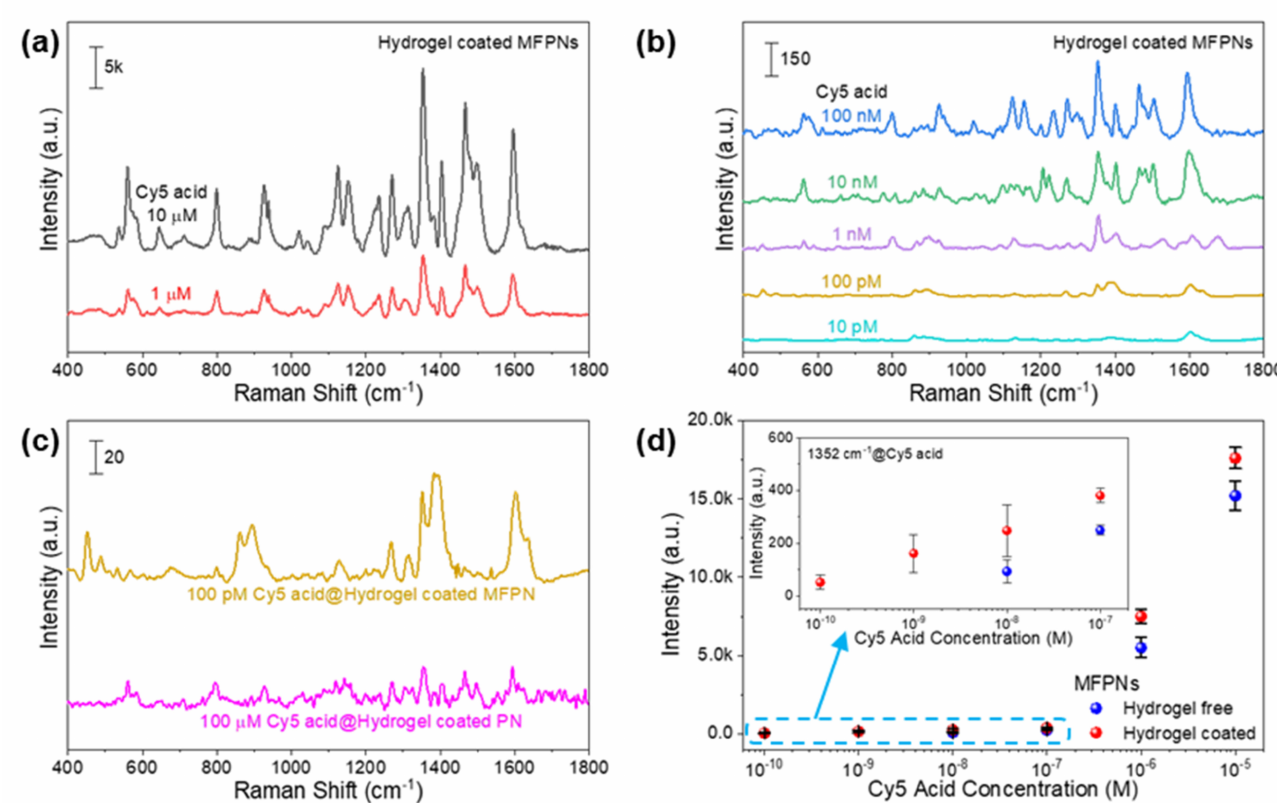
Figure 2. Sensitivity and LOD of the metal film (Au/Ag) over polyimide nanopillars (PNs)(MFPNs) with and without the hydrogel skin. Quantitative SERS analysis of the hydrogel-coated MFPNs for Cyanine5 (Cy5) acid concentrations of ( a ) 1 − 10 µ M and ( b ) 10 pM to 100 nM. ( c ) Raman spectra of the plasmonic and nonplasmonic substrates encapsulated with hydrogel matrix. ( d ) Quantitative Raman intensity at 1352 cm − 1 between the MFPNs with and without the hydrogel layer in Cy5 acid at concentrations ranging from 100 pM to 10 µ